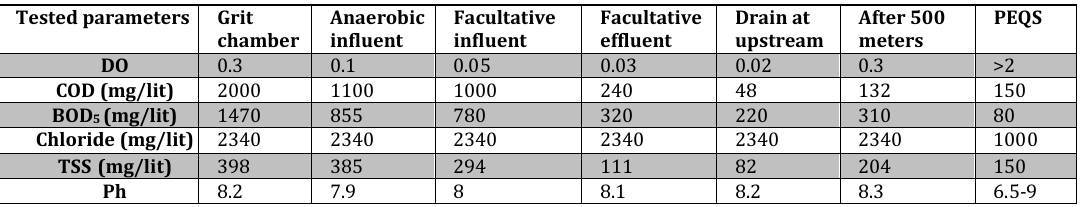
Table 2: Water quality parameters along with PEQS standard